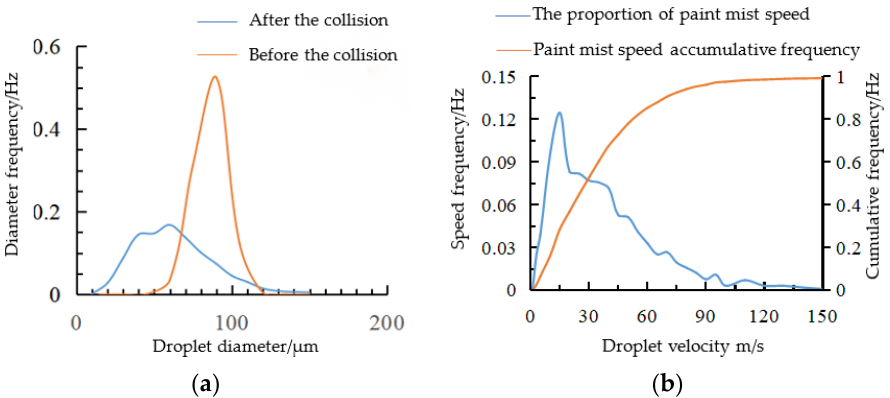
Figure 18. Statistics of the paint mist diameter and velocity: ( a ) Droplet diameter statistics; ( b ) Droplet velocity statistics.